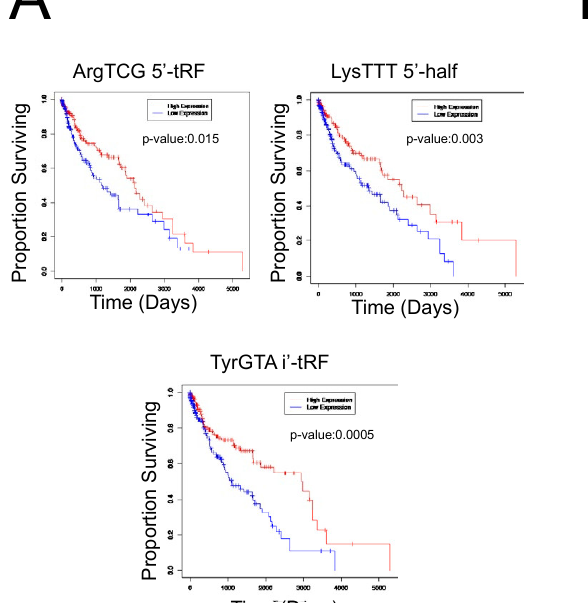
Figure 2. Clinical significance of tRFs in LUSC primary tumor samples. ( A ) Select survival plots demonstrating the decreased expression of the respective tRF with worse patient survival outcomes. The red curve represents high expression of the tRF, while the blue curve represents low expression of the tRF. When the high expression curve is above the low expression curve in the graph, it demonstrates that the decreased expression of the tRF is correlated to worse patient survival outcomes. ( B ) Select survival plot demonstrating the increased expression of the respective tRF with worse patient survival outcomes. The red curve represents high expression of the tRF, while the blue curve represents low expression of the tRF. When the high expression curve is below the low expression curve in the graph, it demonstrates that the increased expression of the tRF is correlated to worse patient survival outcomes.